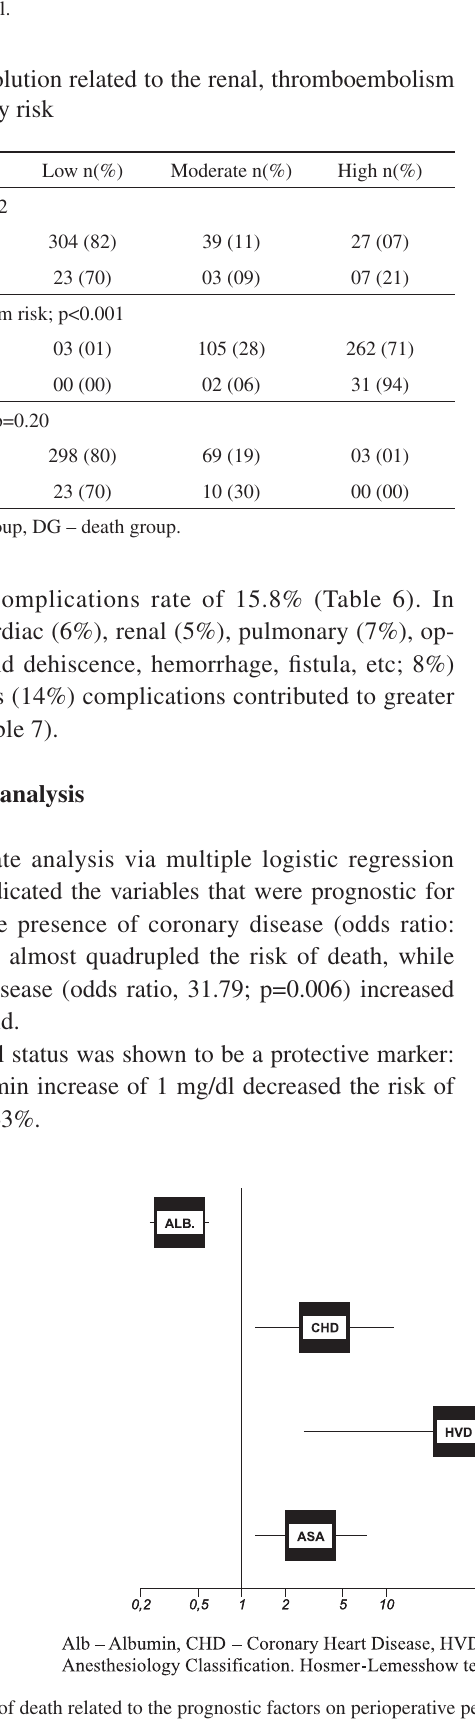
Figure 1 – Odds of death related to the prognostic factors on perioperative